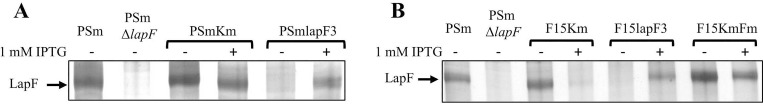
The presence of LapF in the cell lysates of P. putida.(A) Presence of LapF in the cell lysates of P. putida PSmKm and PSmlapF3; (B) Presence of LapF in the cell lysates of F15Km, F15lapF3 and F15KmFm. P. putida PSm and PSmΔlapF were used as controls. Bacteria were grown for 18 hours in LB medium and total protein lysates were prepared. The supplementation of 1 mM IPTG is shown by”+” on the top of figure.